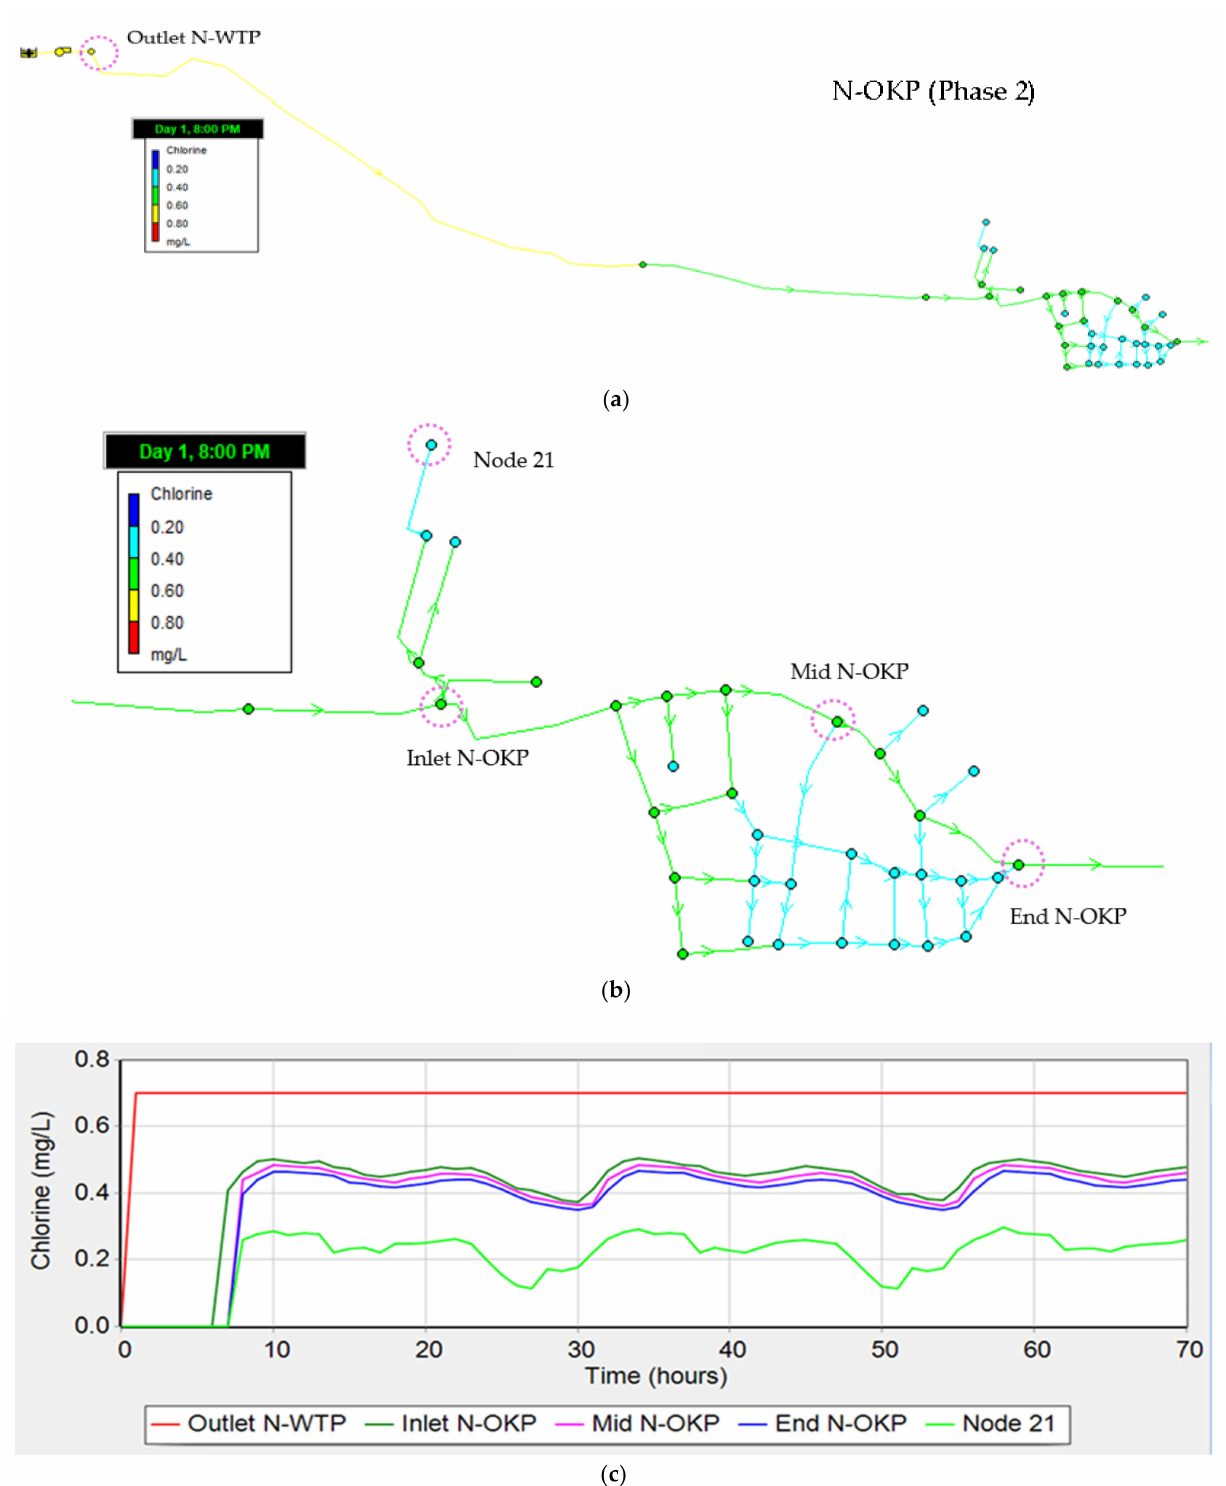
Figure A5. Simulation of chlorine in Phase 2 (initial chlorine 0.7 mg/L): ( a ) Phase 2 model, ( b ) chlorine in N-OKP, and ( c ) chlorine concentration in